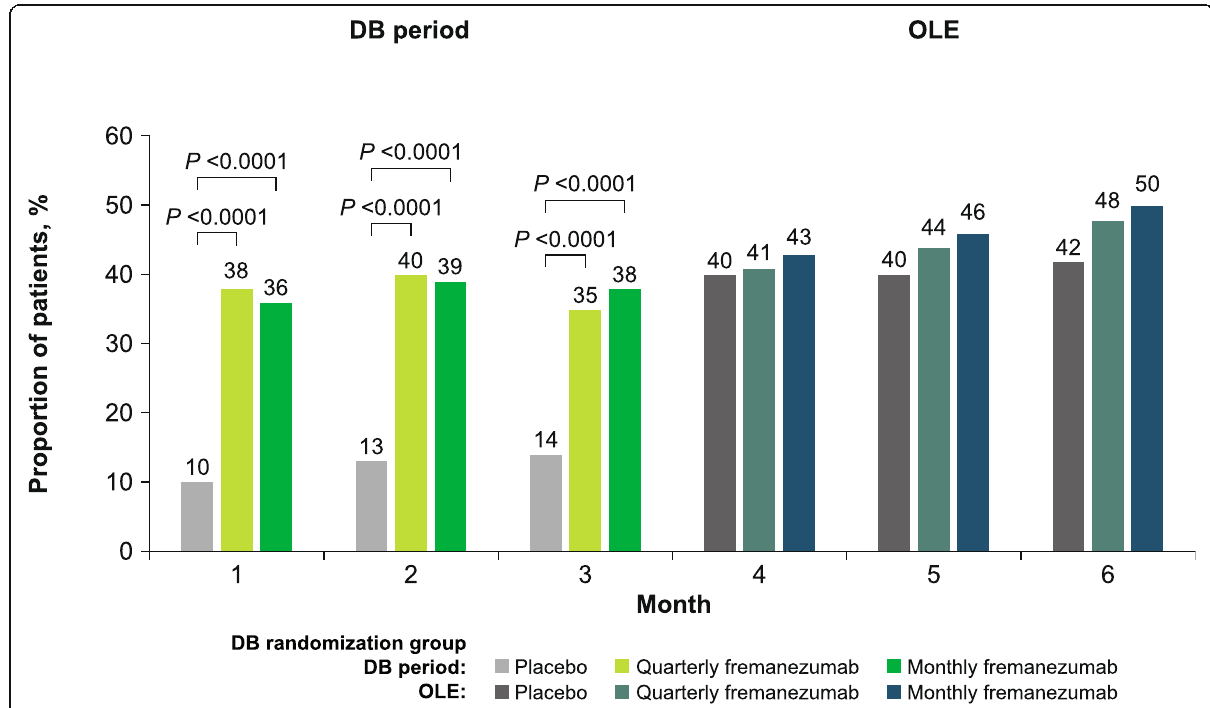
Fig. 5 Proportion of patients achieving ≥ 50% reduction in the monthly average number of migraine days over 6 months (mITT). a mITT, modified intent-to-treat; DB, double-blind; OLE, open-label extension. a All patients in the OLE received fremanezumab 225 mg monthly